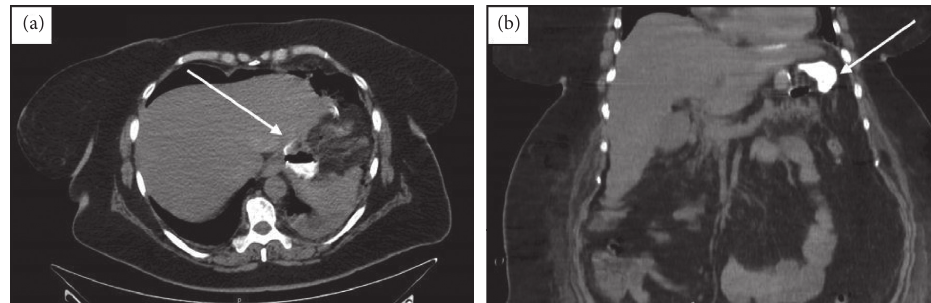
Figure 2: The early complicated patient, shown on axial (a) and coronal (b) CT-scan during the portal phase. CT images show the GL and corresponding collection on the 2 nd POD (Figure 2(a), white arrow). The gastric fistula linking the stomach and enhanced collection (white arrow) are